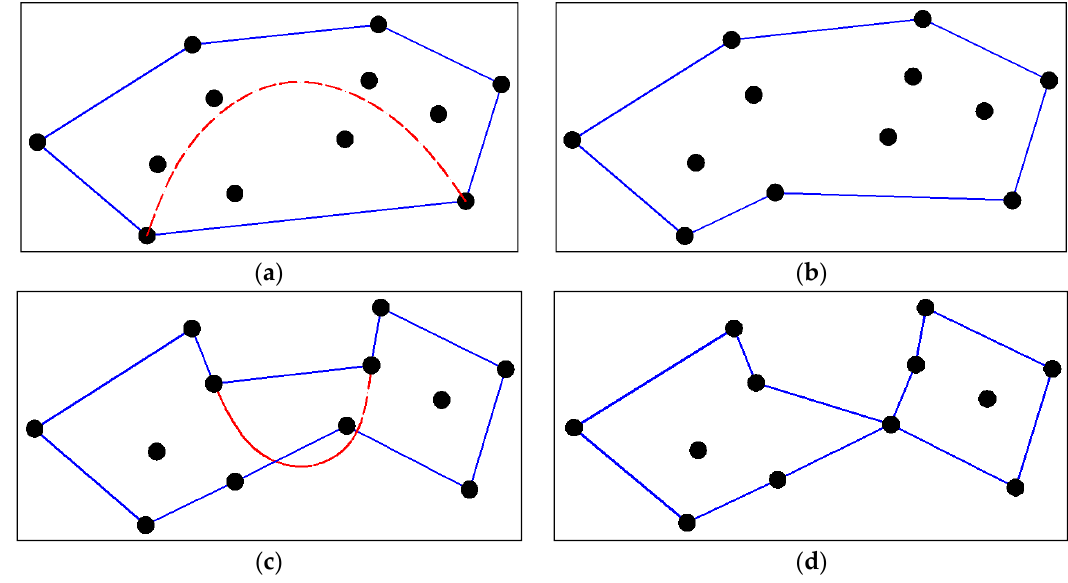
Figure 1. Sketch maps of retracting borderlines. ( a ) The parabola retraction structure. ( b ) Borderlines retracting for the first time. ( c ) Intersecting borderlines. ( d ) Cluster division.